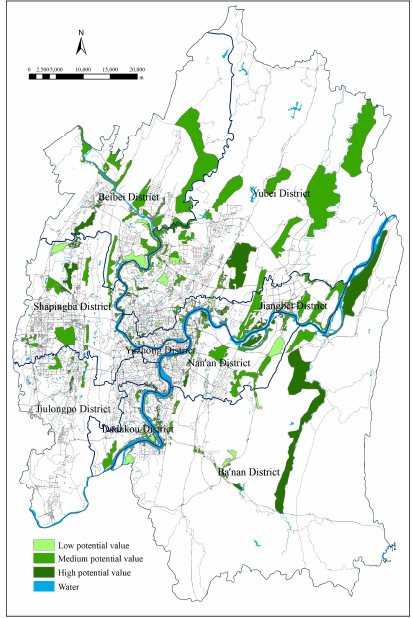
Figure 4. UGS potential map after adaptability evaluation.